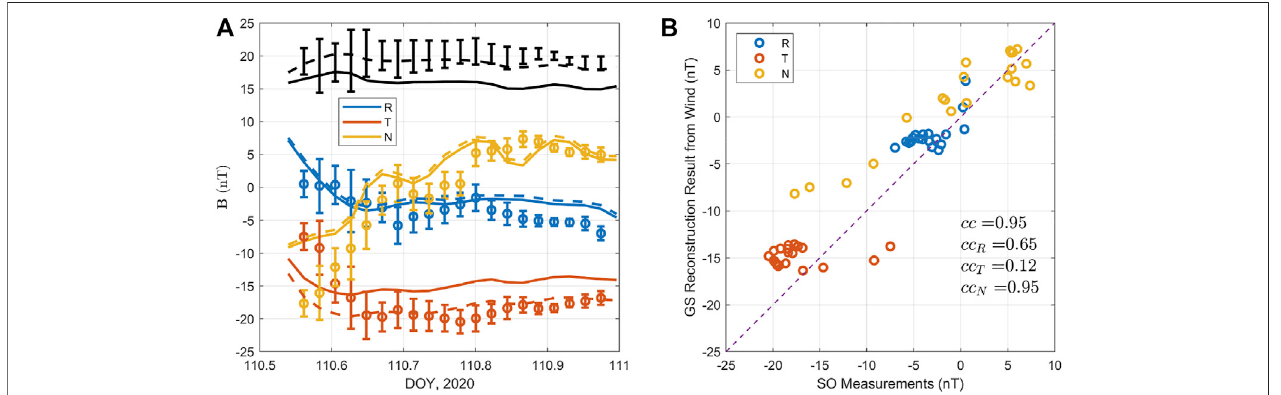
FIGURE 5 | (A) The comparison between the derived magnetic fi eld components (solid curves) based on the GS reconstruction result from Wind in Figure 2 , and the actual measurements (circles and error bars), along the SO spacecraft path. The fi eld magnitude is in black. (B) The corresponding component-wise one-to-one scatter plot with the correlation coef fi cients between the two sets for all three components, cc , and each individual component are denoted. The dashed line marks the one-to-one diagonal line. The dashed curves in (A) represent an alternative estimate/adjustment based on an argument of the 1 / r h dependence of the axial fi eld.